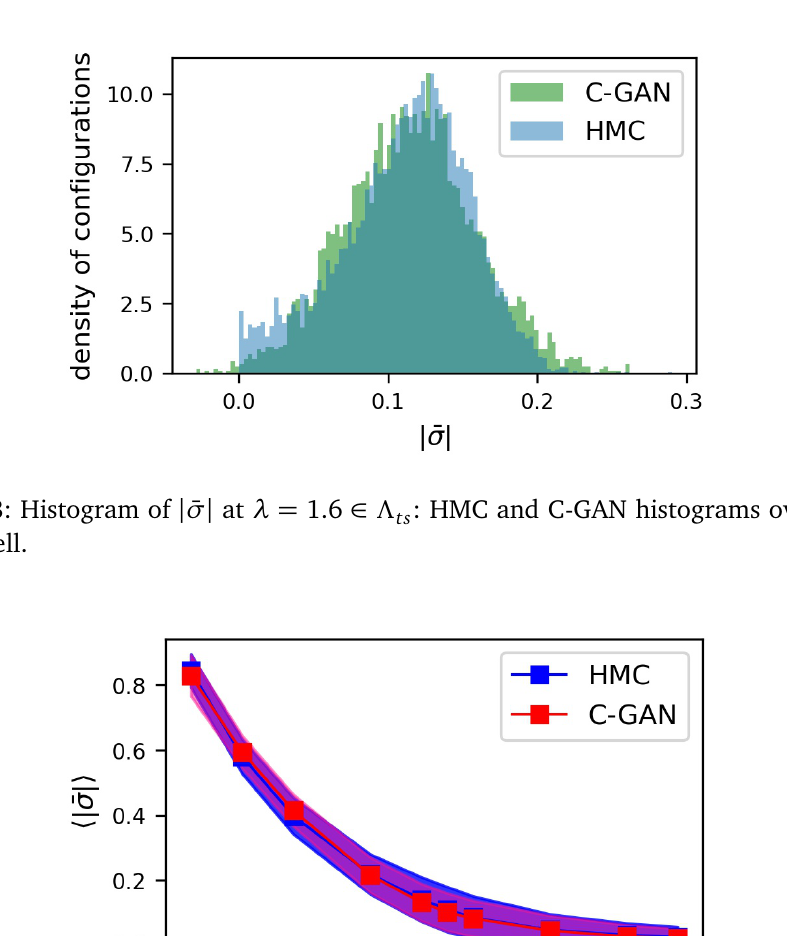
Figure 7: Histogram of | ¯ σ | at λ = 1.5 ∈ Λ quite well.